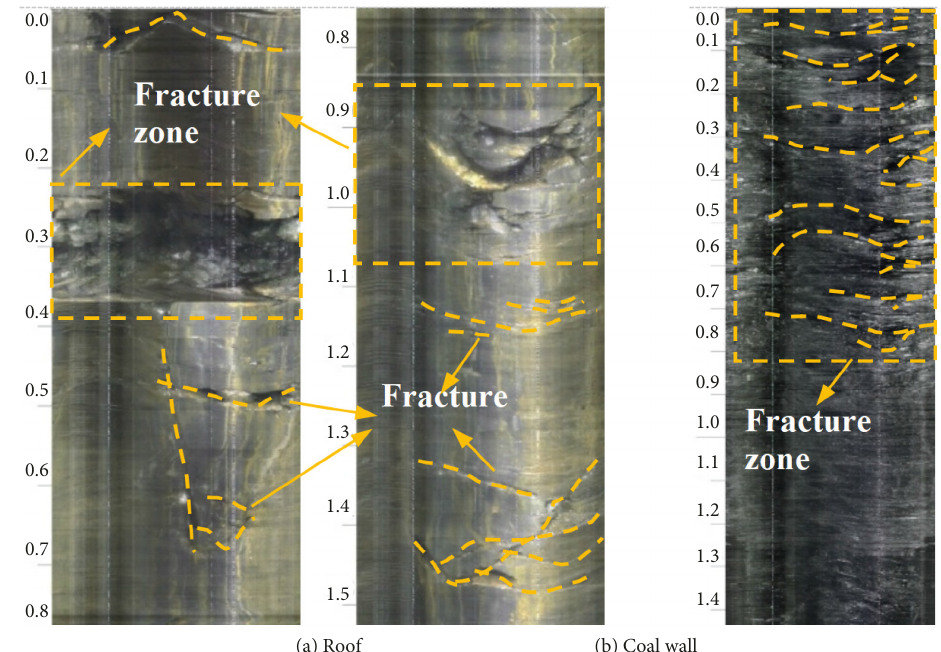
Figure 5: Borehole optical observation in roof and coal seam